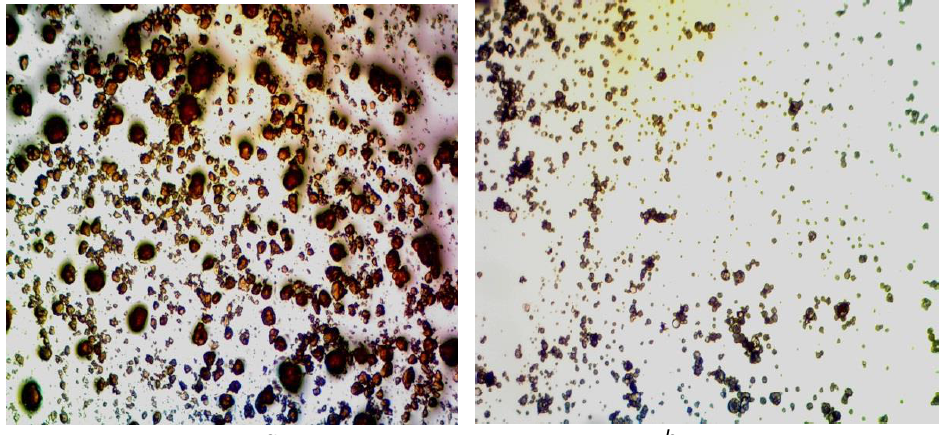
Fig. 1. Photo of dry substances: a – diosmin; b –